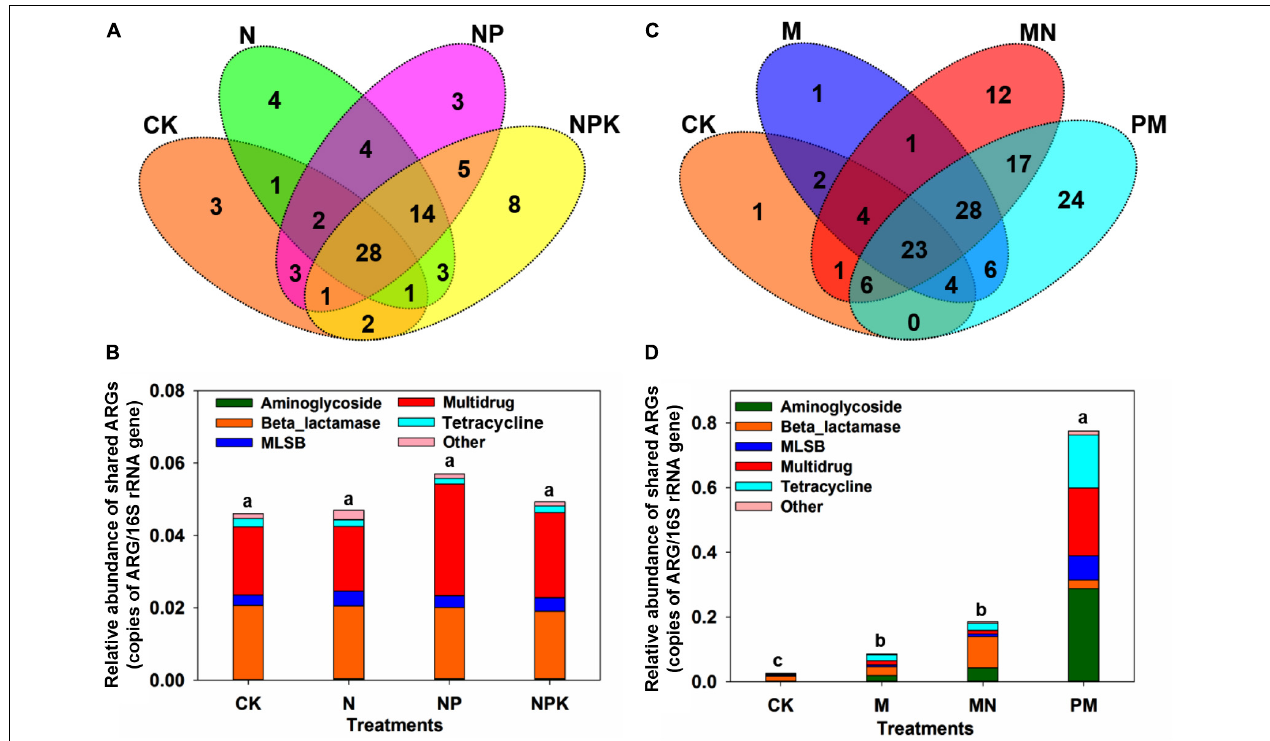
FIGURE 3 | (A) Venn diagram illustrating the ARGs shared by the CK, N, NP, and NPK treatments. (B) The relative abundance of ARGs shared among the CK, N, NP, and NPK treatments. (C) Venn diagram illustrating the ARGs shared by the CK, M, and MN treatments and PM. (D) The relative abundance of ARGs shared among the CK, M, and MN treatments and PM. MLSB, macrolide-lincosamide-streptogramin B. Different letters indicate significant differences of means in pairwise comparisons (Duncan’s test, P < 0.05) for each treatment.